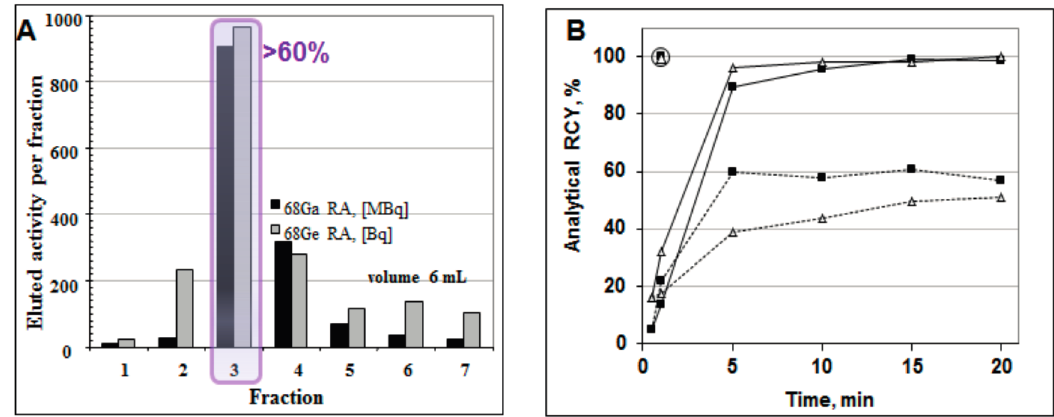
Figure 8. ( A ) Elution profile of the 68 Ge/ 68 Ga generator where one fraction was 1 mL (except for fraction 1 (0.3 mL) and fraction 7 (0.7 mL)), giving a total eluted volume of 6 mL. The profiles for the 68 Ga elution and the 68 Ge breakthrough are similar; the 68 Ge breakthrough is ~10 − 3 %. Fraction 3 (1 mL) contains over 60% of the available 68 Ga radioactivity; ( B ) Time course of 68 Ga complexation reaction conducted using 1 mL peak fraction of the generator eluate at room temperature ( dashed line ), conventional heating at 95 °C in a heating block ( solid line ), and with microwave heating at 90 ± 5 °C for 1 min ( circled ) for two different buffer systems: ■ sodium acetate buffer, pH = 4.6, 20 nmol of DOTA-TOC; ∆ HEPES buffer, pH = 4.2, 5 nmol of